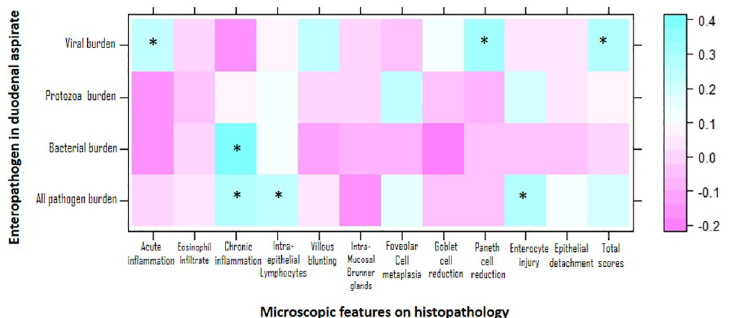
Fig 5. Correlation coefficient matrix of pathogens in the duodenal aspirate with the histopathological features in cases (n = 60). Values are Spearman’s correlation coefficients. � p < 0.05. The following were studied as continuous variable: presence of any pathogens, bacteria, protozoa, viruses and all histopathological features.